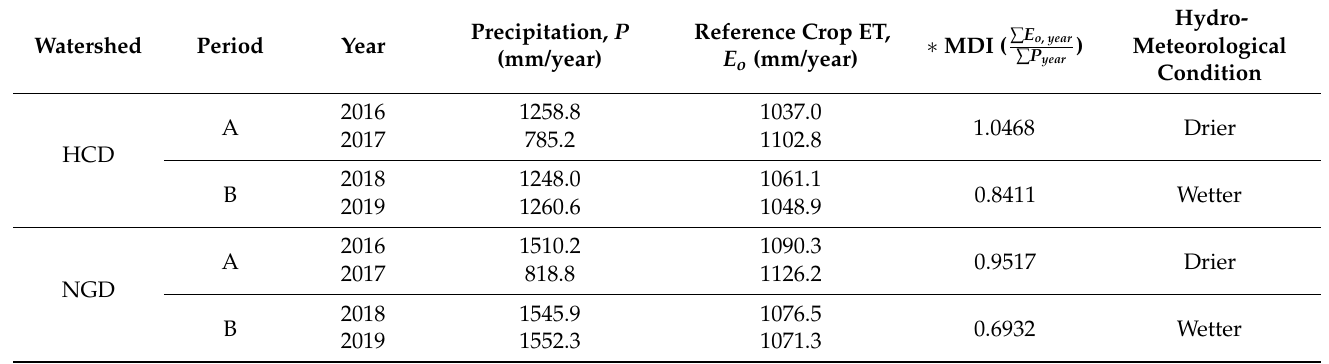
Table 5. Hydroclimatic conditions for calibration